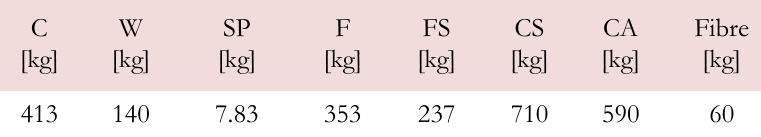
Table 1: Mix composition of steel fibre reinforced self-compacting concrete per m 3 .